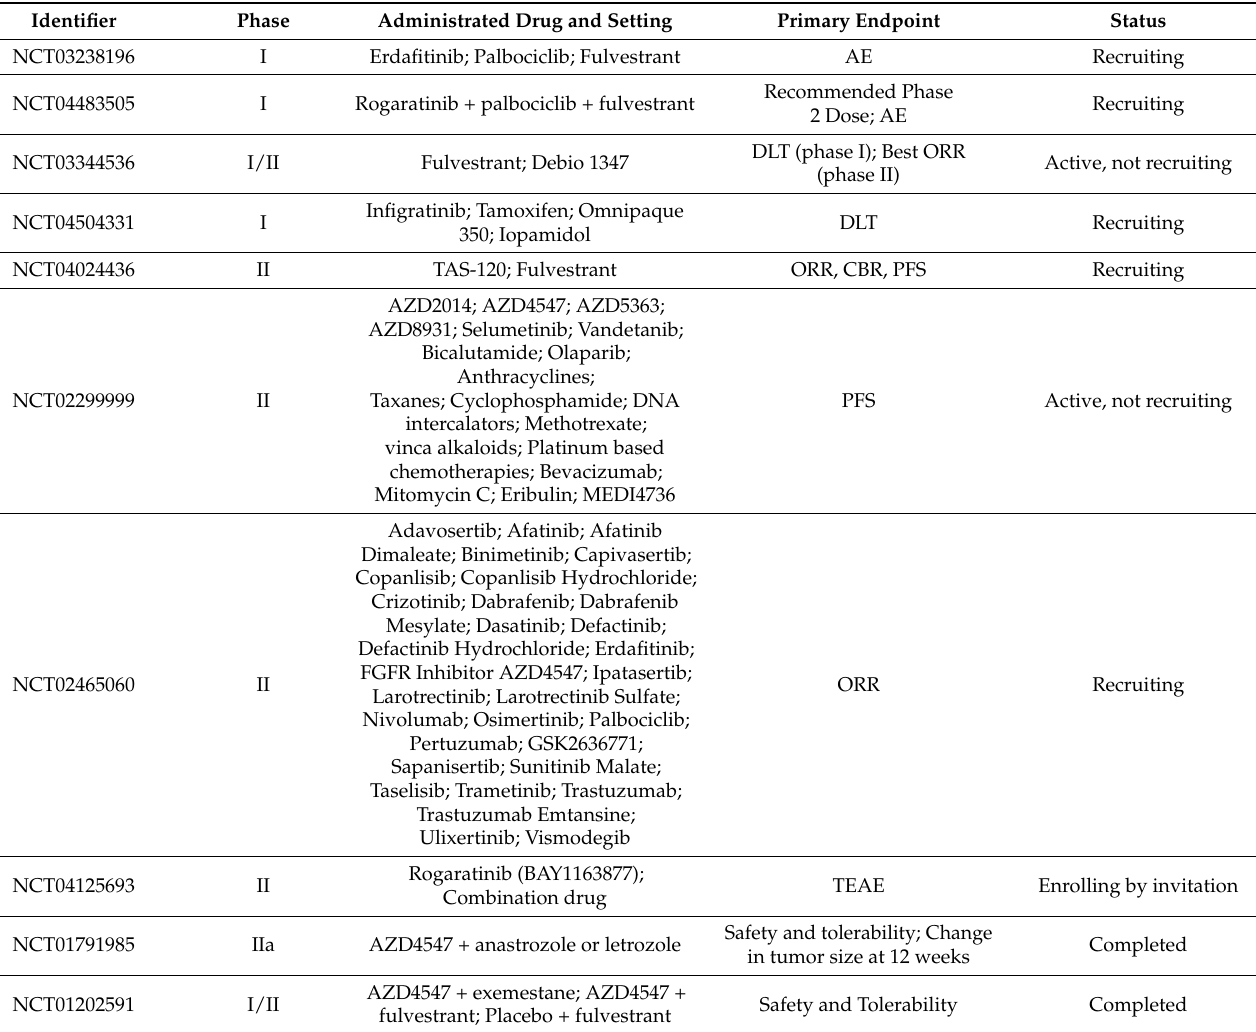
Table 1. Clinical trials using selective fibroblast growth factor receptor (FGFR) inhibitors in breast